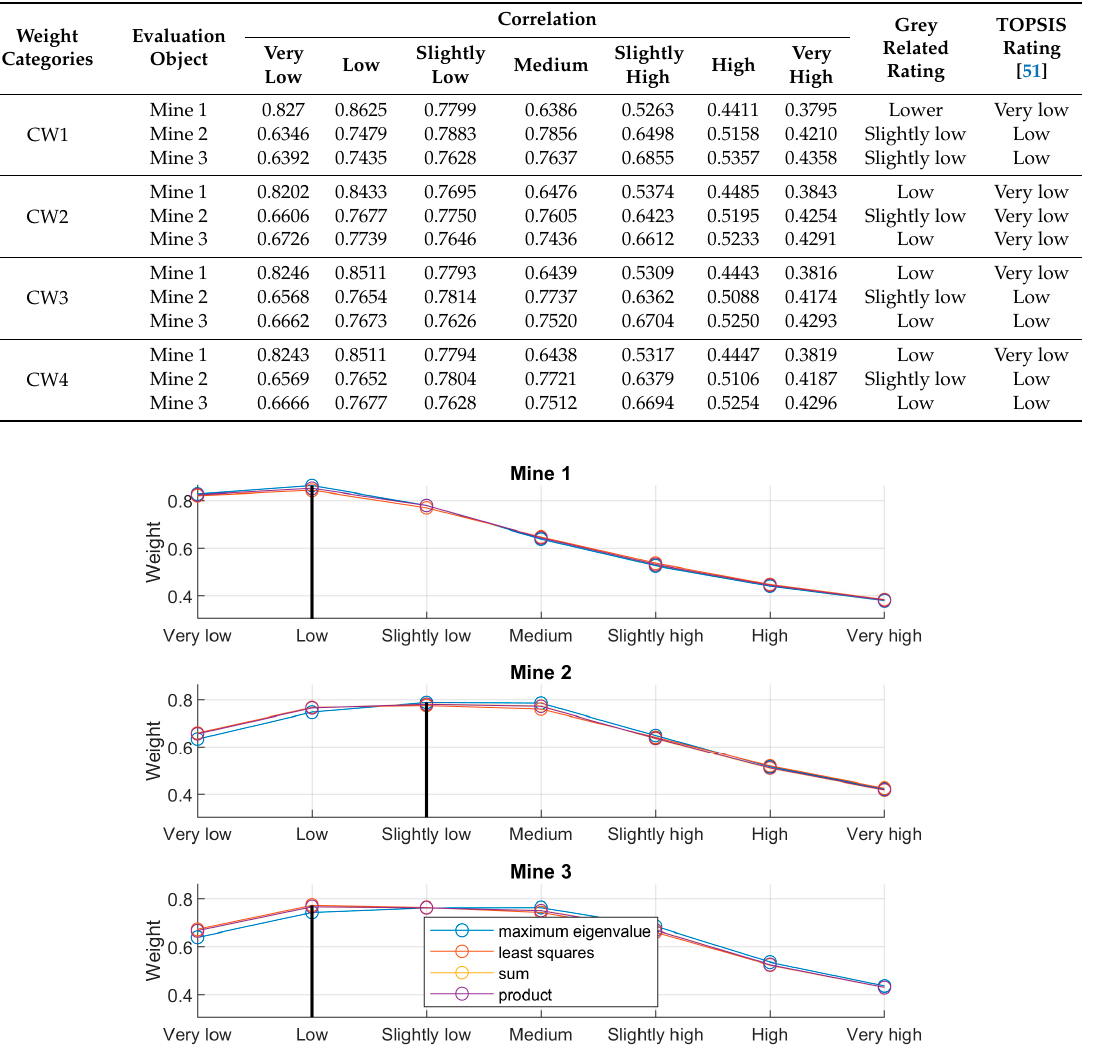
Figure 4. Fuzzy-grey correlation based on the relaxed attitude.